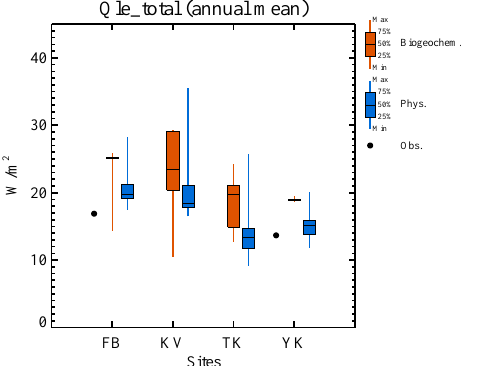
Figure 7. As for Fig. 3, except the plot displays annual gross primary production. The relevant biogeochemical models include BEAMS, Biome-BGC, CHANGE, LPJ, SEIB-DGVM, STEM1, and VISIT. The observation shows the average values for 2011– 2013 and 2004–2012 at FB and YK, respectively.